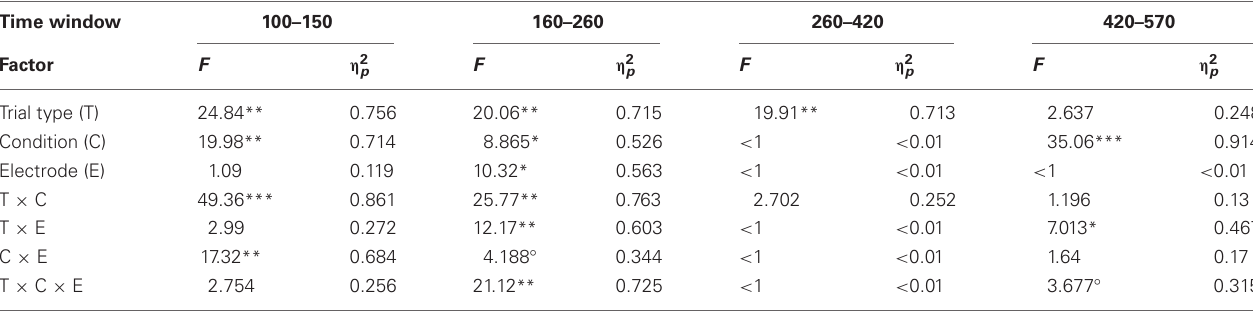
Table 4 | Statistical evaluation of effects of Trial type (rare vs. frequent), Condition (Oddball vs. Distractor), and Electrode (Fz vs. Cz) by means of repeated-measure ANOVAs separately for the four time windows in Experiment